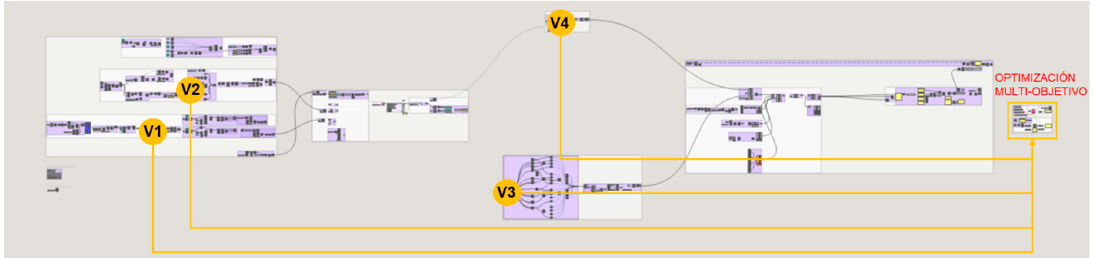
Figure 36. Location of the variables considered in the multi-objective optimization problem within the programming structure definition of the methodology for the case study.